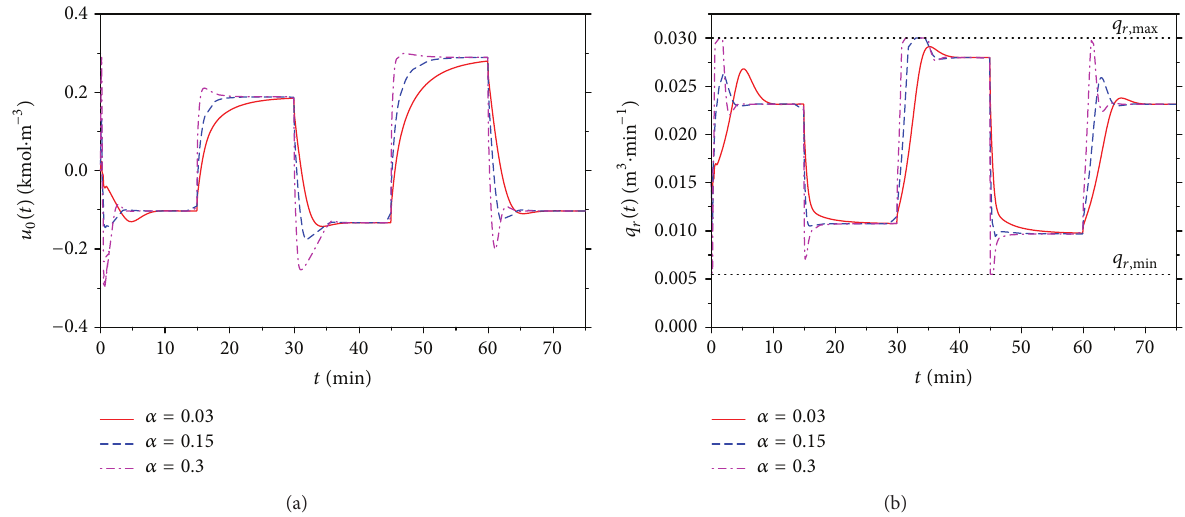
Figure 13: Outputs from the LDP 𝑢 0 or various values of 𝛼 (a) and the courses of the computed input variable, 𝑞 𝑟 , to the ELM for various 𝛼 (b).